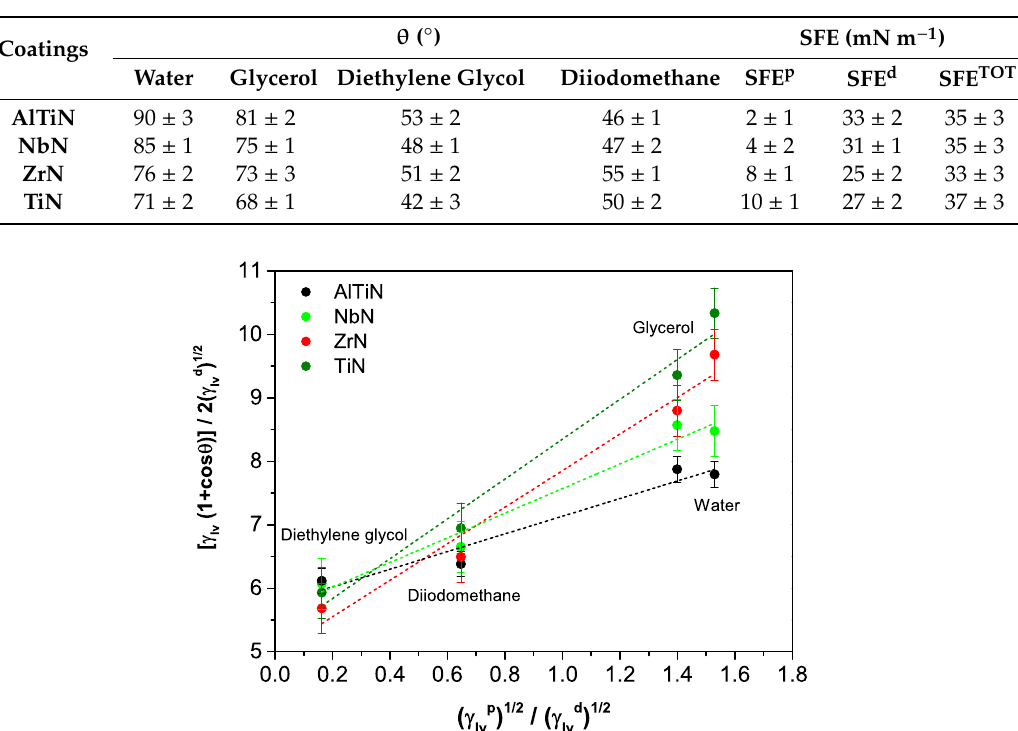
Table 2. Contact angle values by using different solvents for the tested samples and relative Surface Free Energy (SFE) of the investigated coatings, alongside with both polar (SFE p ) and disperse (SFE d ) components.